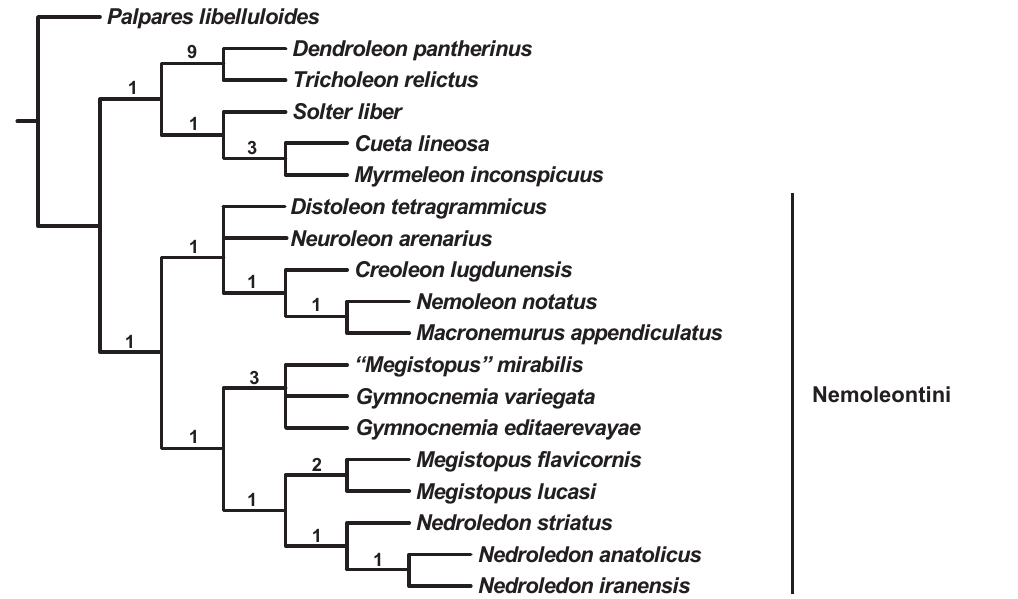
Figure 11. Strict consensus tree obtained from the two most-parsimonious trees with Bremer support values indicated above branches.